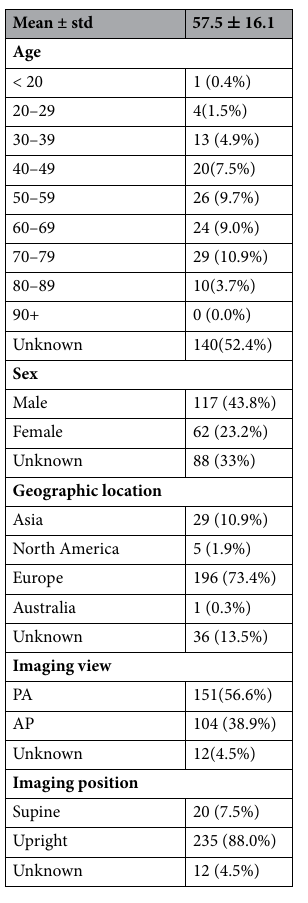
Table 1. Summary of demographic variables and imaging protocol variables of CXR data used in this study. Age, sex, and geographic location statistics are expressed on a patient level, while imaging view and imaging position statistics are expressed on an image